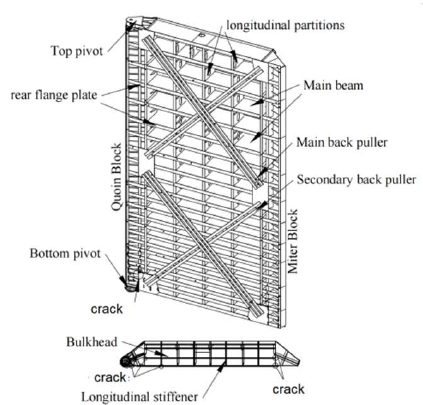
Figure 1. Gezhouba No. 2 miter gate structure.